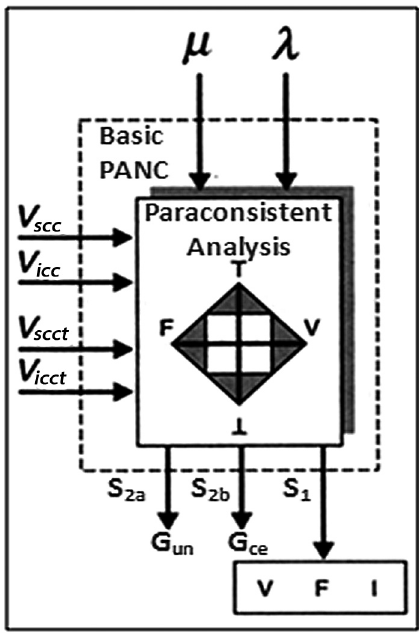
Figure 2 - Basic cell of